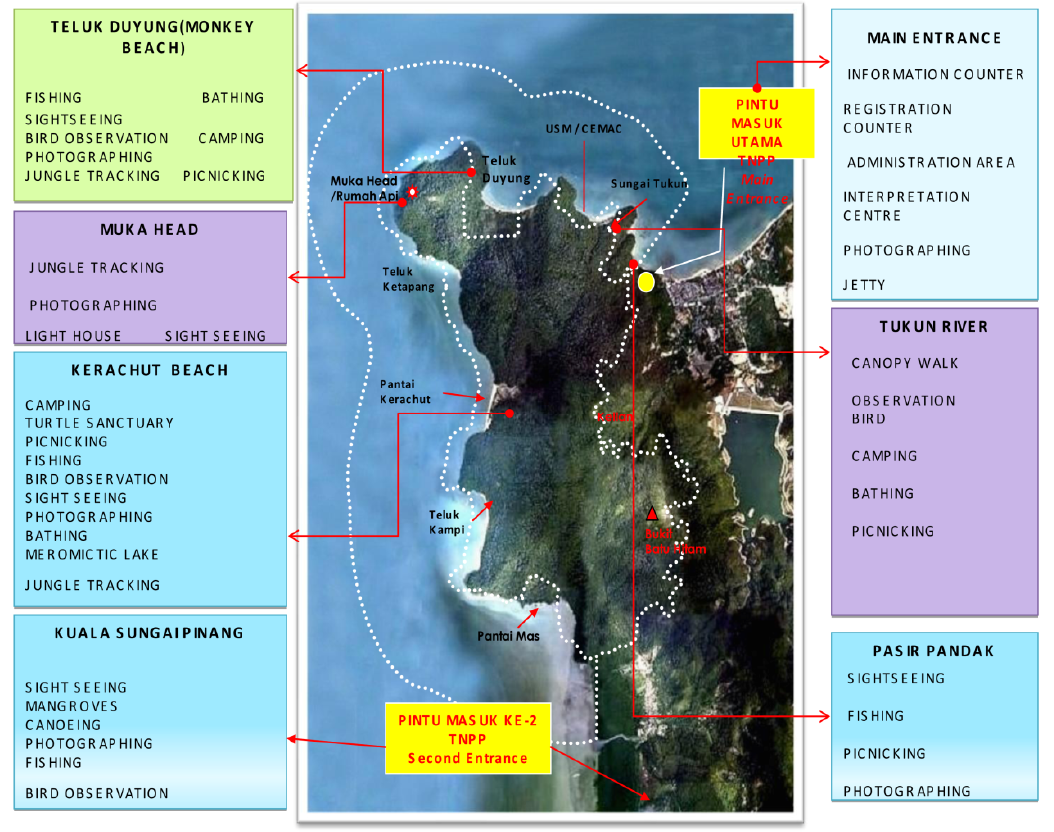
Figure 1. Penang National Park (Locations and Activities) [4]. Source: Modified